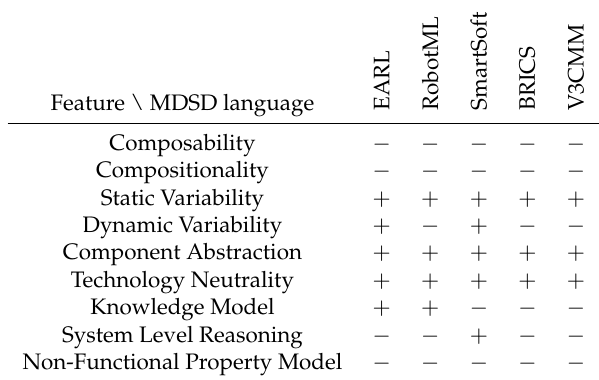
Table 8. Comparison of robotic MDSD languages; feature: ( + ) exists, ( − ) does not